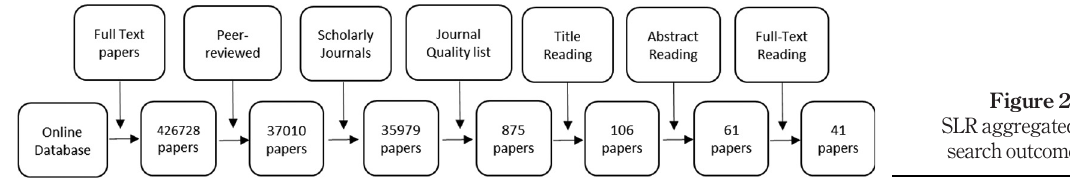
Figure 1. SLR methodological procedure fl ow